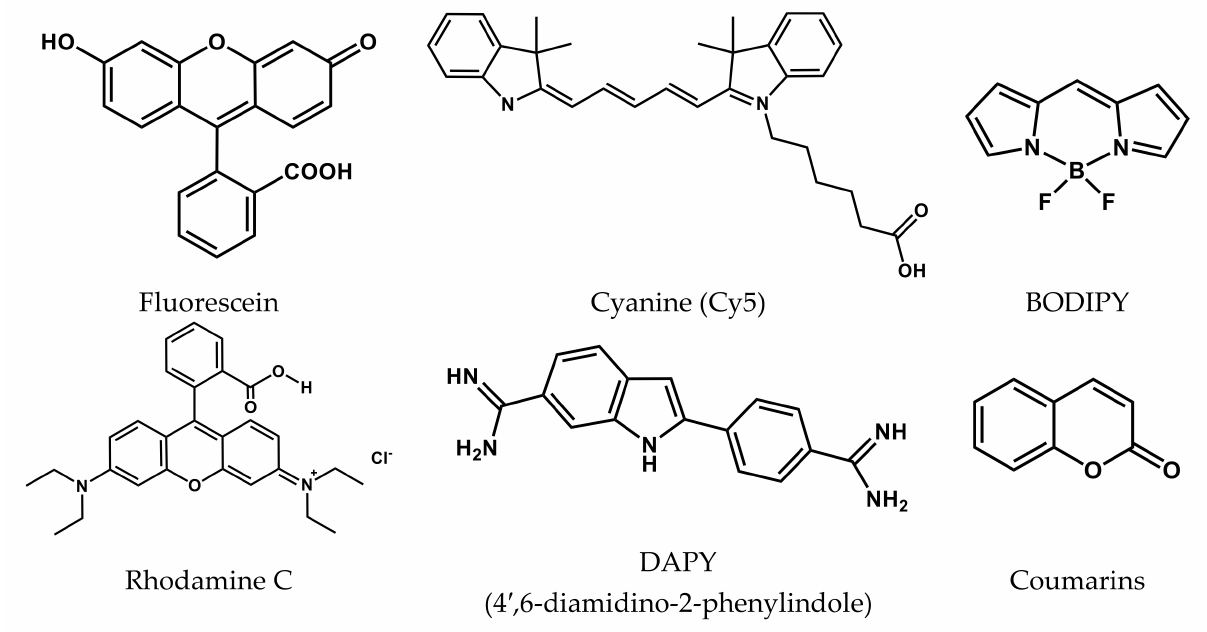
Figure 1. Structures of organic